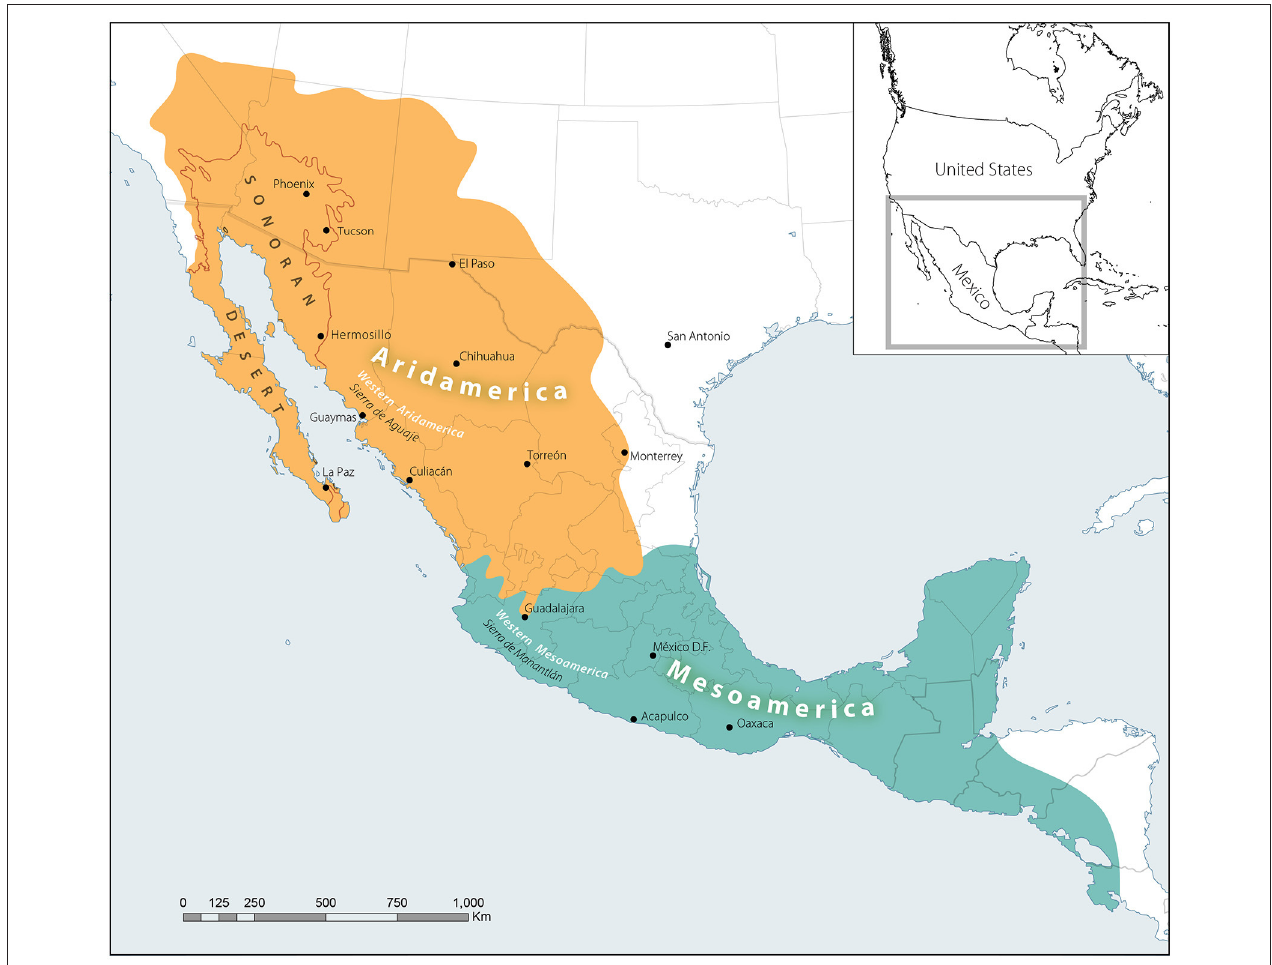
FIGURE 1 | Aridamerican and Mesoamerican Centers of Diversity. Modified from Kirchhoff (1954, 2000), Nabhan (1985), and Nabhan et al.